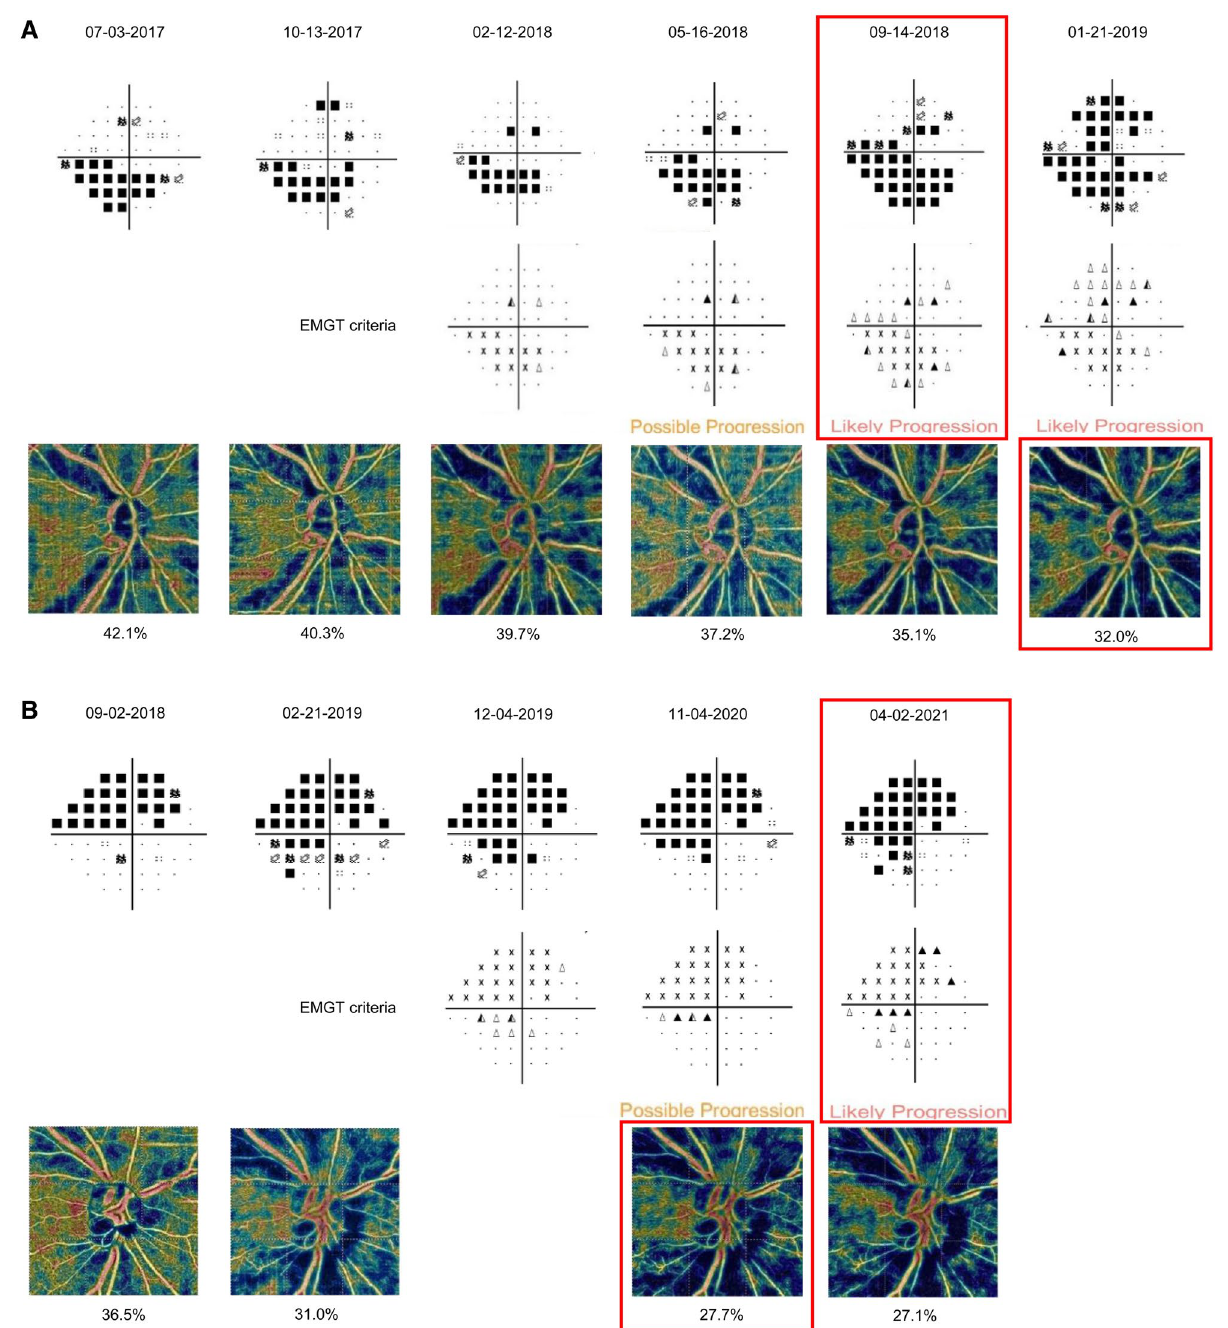
Figure 2. Two representative cases ( A , B ) with primary open-angle glaucoma showing progressive reduction of circumpapillary vessel density (cpVD) and visual field (VF) progression. ( A ) Representative case of a 76-year- old man with a VF mean deviation of − 10.95 dB at baseline demonstrated VF progression preceded by cpVD reduction. Significant progressive VF progression (“likely progression”) was detected on September 14, 2018. Approximately four months later, two consecutive optical coherence tomography angiography (OCTA) tests (on September 14, 2018, and January 21, 2019) showed cpVD reduction the tolerance limit (5.16 %) compared to ≥ baseline cpVD. B. Representative case of a 72-year-old female with VF MD, − 13.43 dB at baseline whose cpVD significantly decreased before VF progression was detected. Two consecutive OCTA tests on February 21, 2019, and November 4, 2020, showed cpVD reduction the tolerance limit (5.16 %) compared to the baseline cpVD. ≥ VF progression was detected on April 2, 2021. cpVD circumpapillary vessel density , dB decibel , EMGT Early Manifest Glaucoma Trial, MD mean deviation, OCTA optical coherence tomography angiography, VF visual